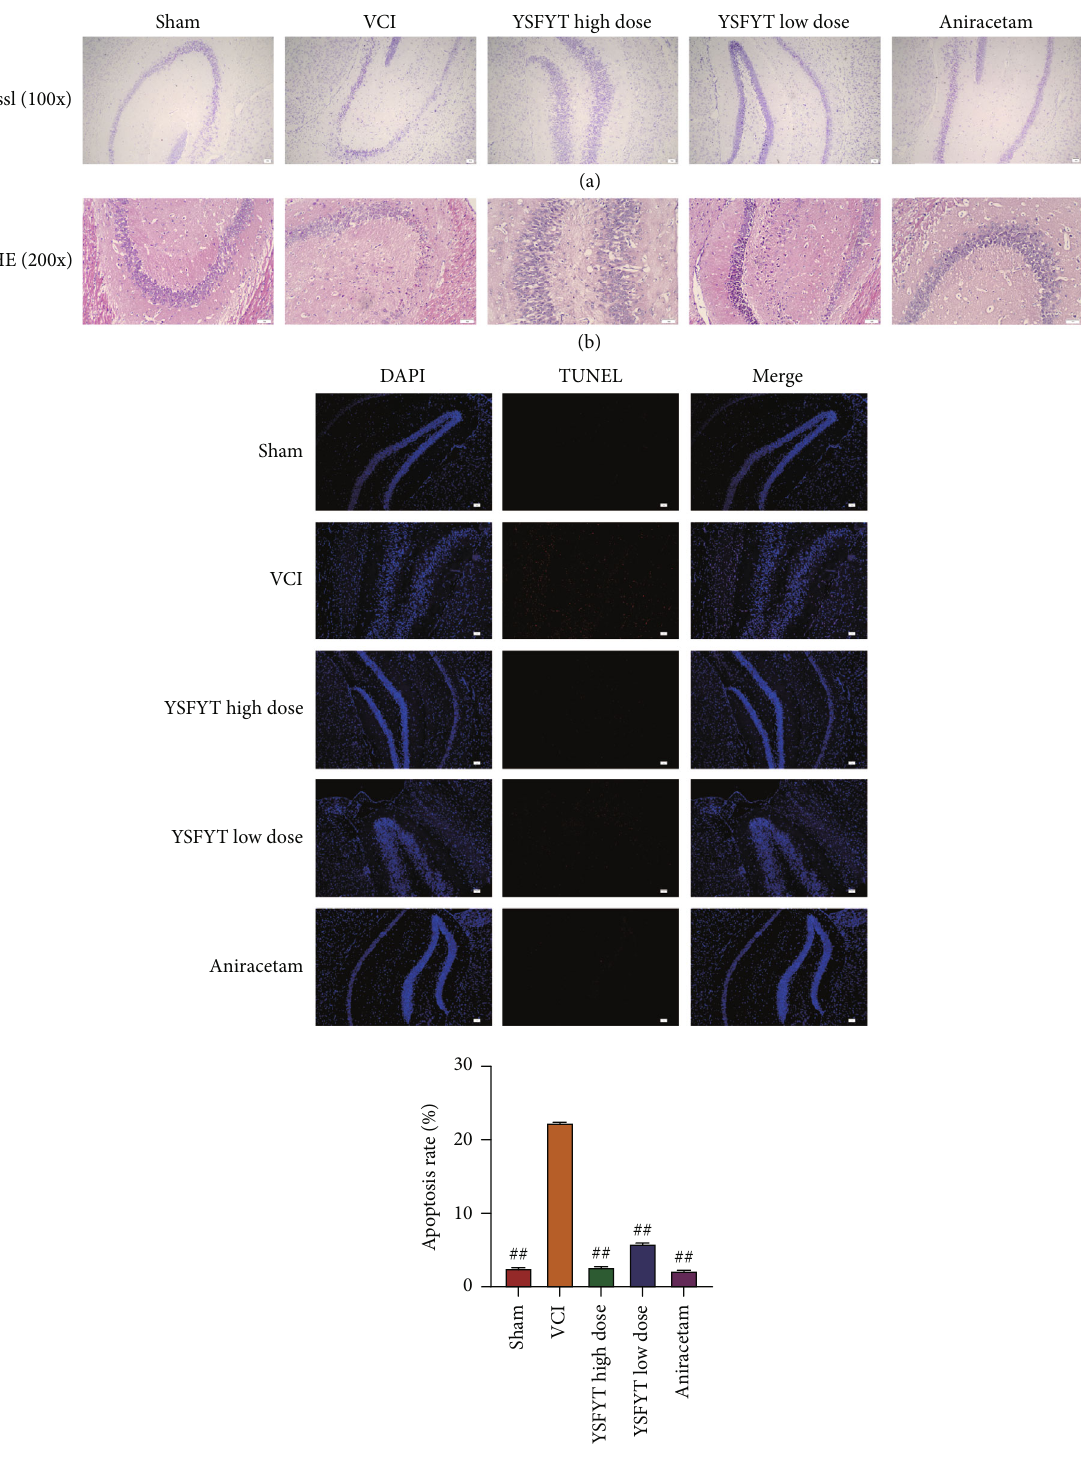
Figure 5: Histological examination of hippocampal neurons. (a) Nissl staining. (b) HE staining. (c) Fluorescence TUNEL assay. The scale bar is 50 μ